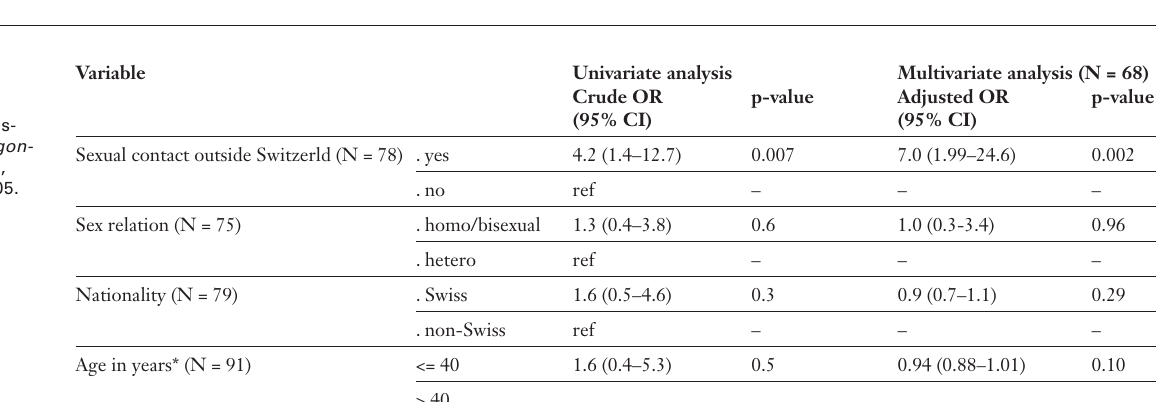
Table 1 Distribution of demo- graphic characteris- tics and some risk ex- posure among pa- tients with N. gonor- rhoeae infection tested or non-tested for ciprofloxacin re- sistance, Geneva 2002–2005.